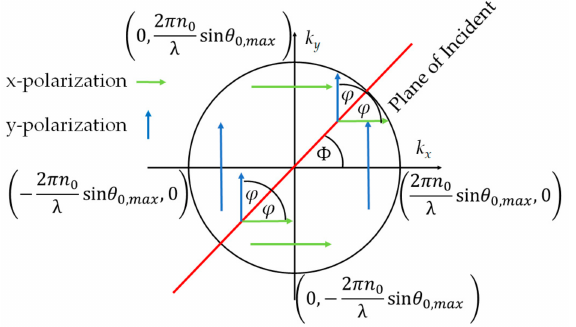
Figure 4. Shows x-polarization in green arrows and y-polarization in blue arrows and their wave vector space at the exit pupil function of the microscope